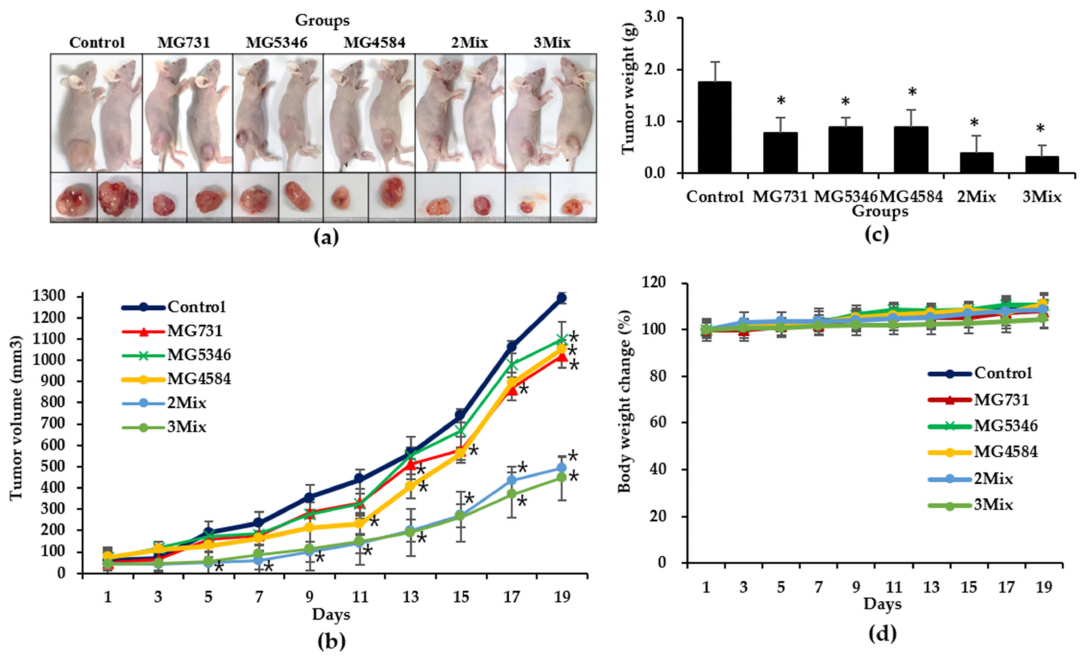
Figure 3. The inhibitory effect of heat-killed Bifidobacterium and Lactobacillus on the growth of RKO cell-derived tumors in xenograft model mice. BALB/c nude mice were subcutaneously injected with 1 × 10 6 RKO cells/mouse into the dorsum next to the right hind leg. The mice were orally administered drinking water, heat-killed single strains, or their mixtures every day for another 19 days. ( a ) Photographs represent tumor size. ( b ) Tumor growth curves. ( c ) Tumor weight. ( d ) Body weight changes. Data represent mean ± SD ( n = 5), * p < 0.05 vs. control. Control, drinking water; MG731, B. bifidum MG731 (1 × 10 9 cells/mouse); MG5346, L. reuteri MG5346 (1 × 10 9 cells/mouse); MG4584, L. casei MG4584 (1 × 10 9 cells/mouse); 2Mix, mixture of L. reuteri MG5346 (1 × 10 9 cells/mouse) and L. casei MG4584 (1 × 10 9 cells/mouse); 3Mix, mixture of B. bifidum MG731 (1 × 10 9 cells/mouse), L.